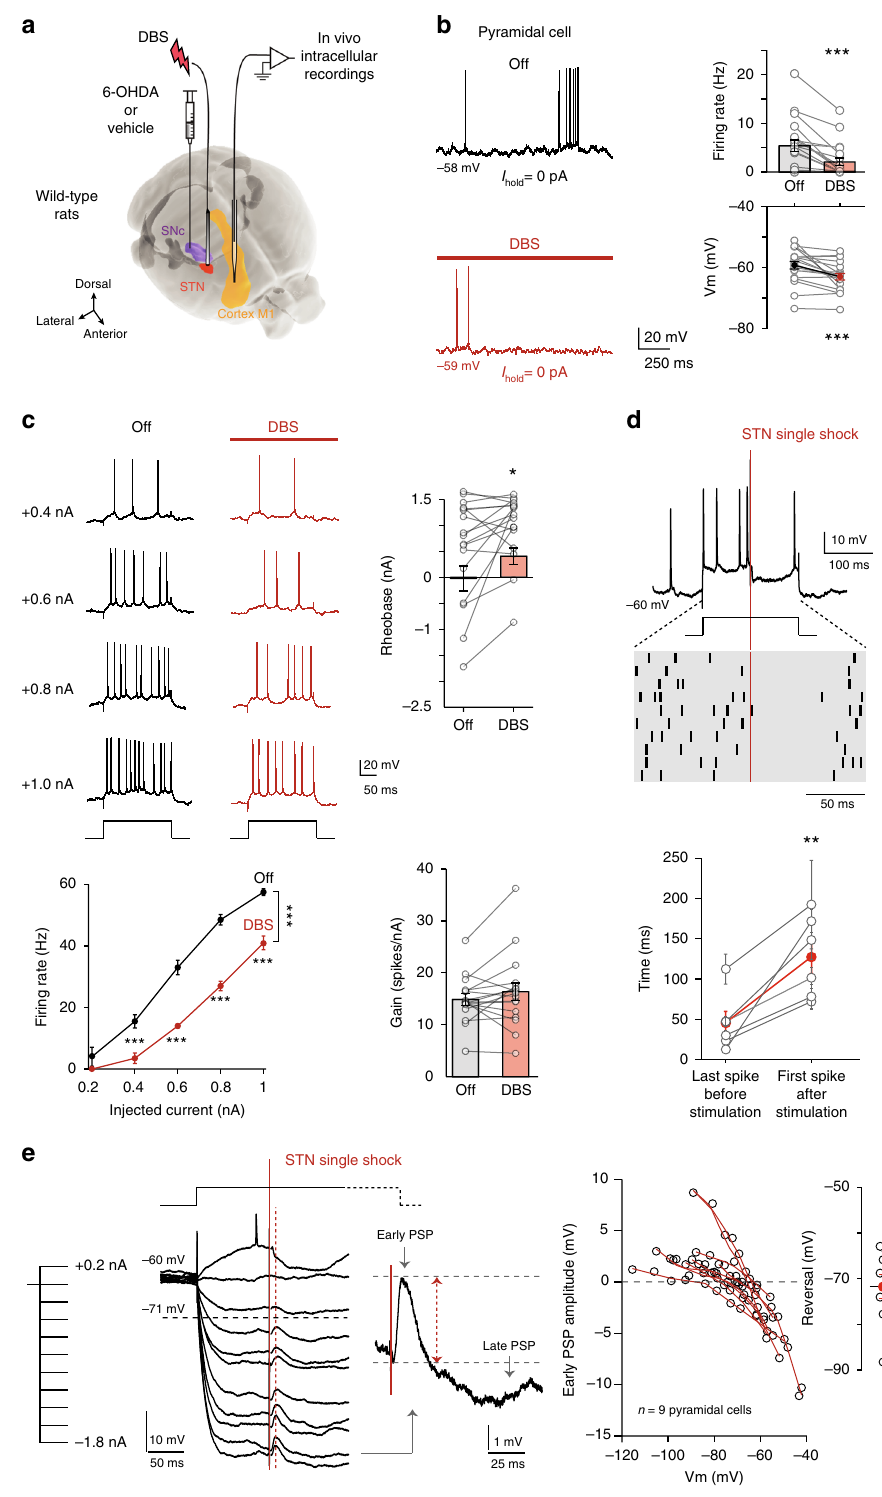
hyperpolarization than opto-activation of PV cells ( p = 0.0371; Fig. 4h), together with a partial release of the spiking inhibition only in Sst::ChR2 mice ( p = 0.0326; Fig. 4e). In addition, the variance of the membrane potential was larger under